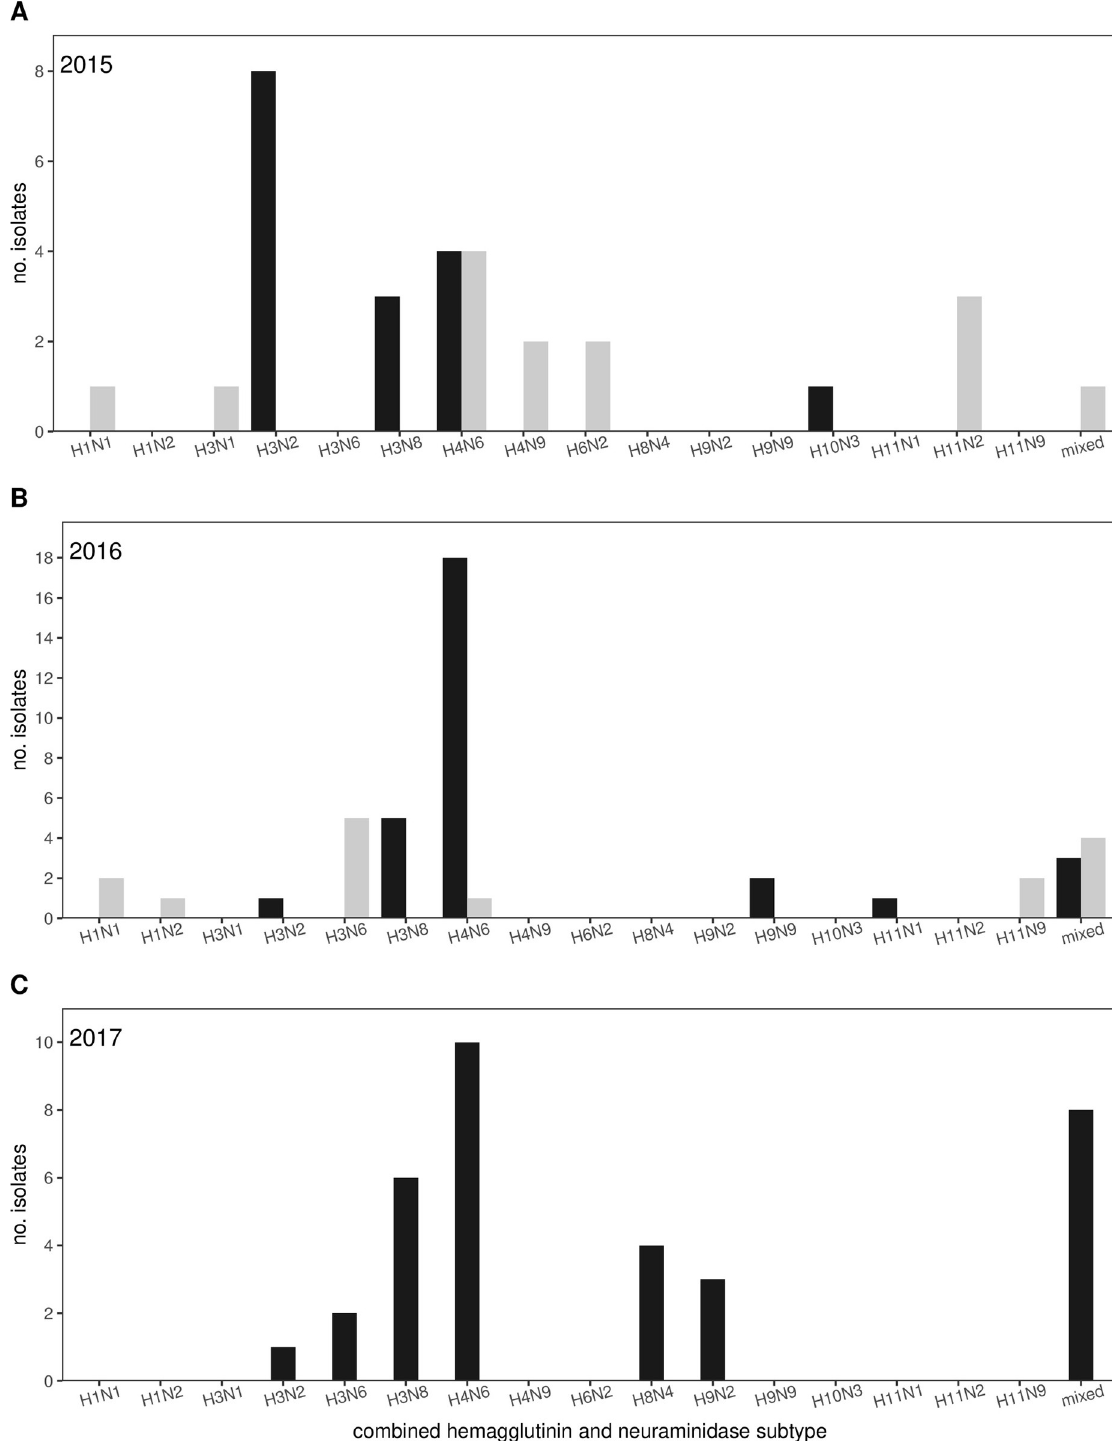
Fig 2. Influenza A virus subtypes detected in this study. Bar charts depicting combined subtypes of influenza A virus (IAV) isolates recovered from samples collected at study sites in Maine (black bars) or Maryland (gray bars) in 2015 (Panel A), 2016 (Panel B), and 2017 (Panel